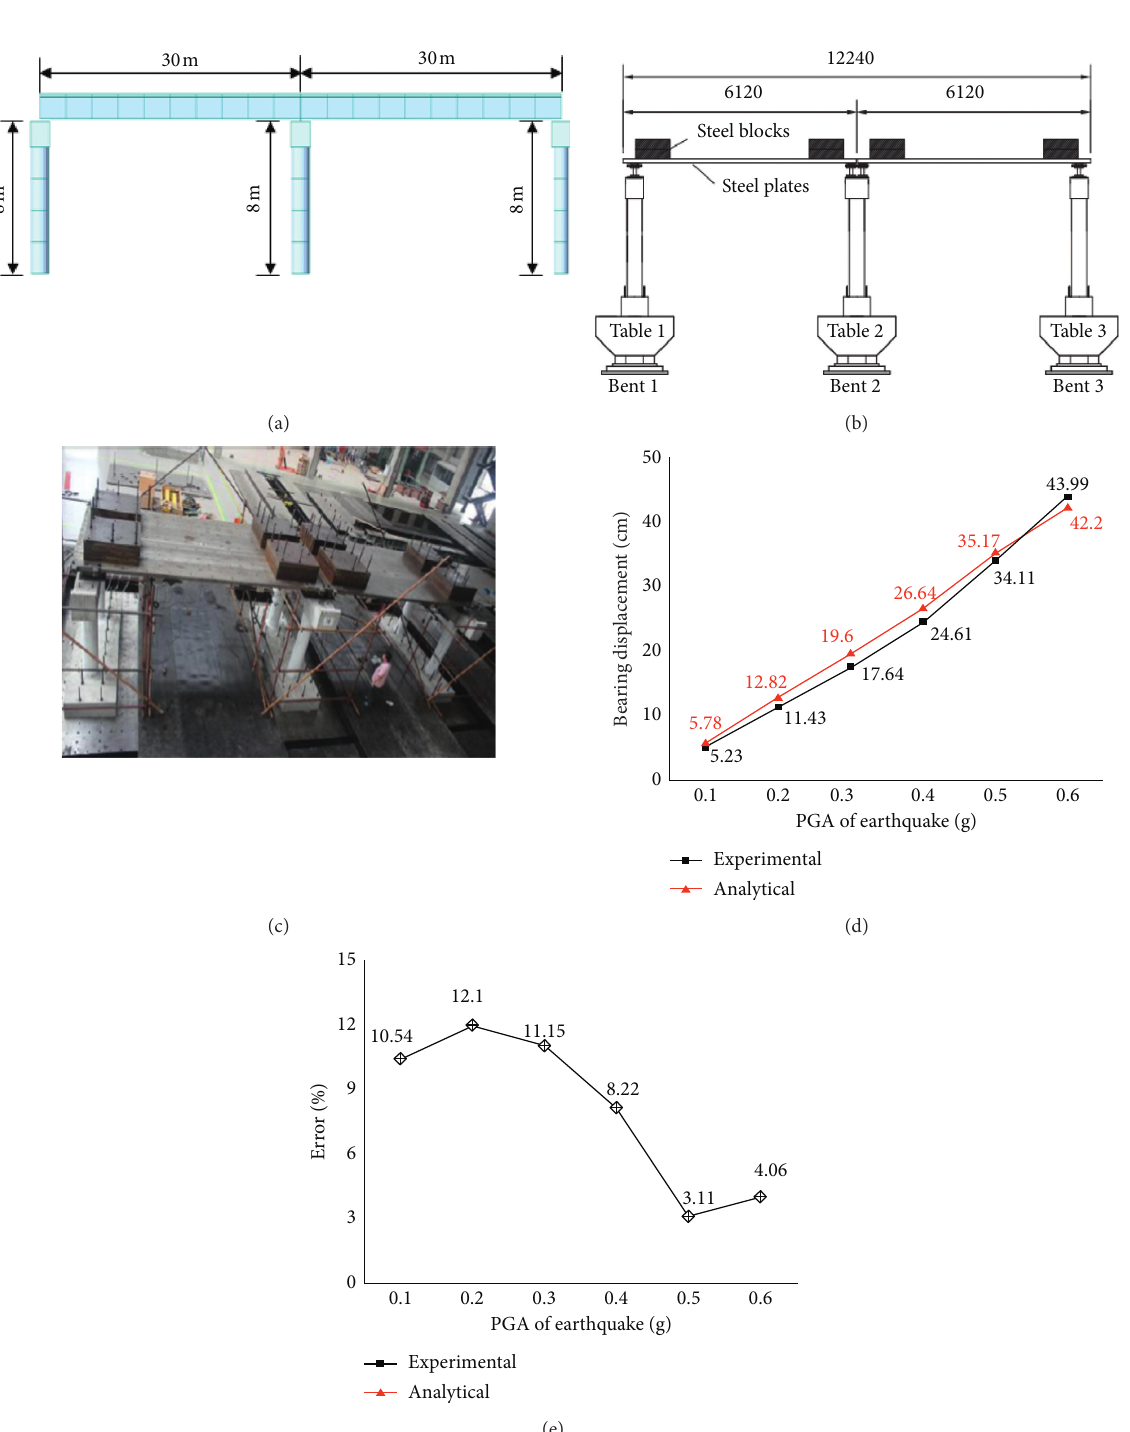
Figure 7: Models and results: (a) analytical model; (b) experimental model; (c) model for the shaking table test; (d) seismic response under different intensities of Northridge earthquake; (e) error analysis of the test and numerical